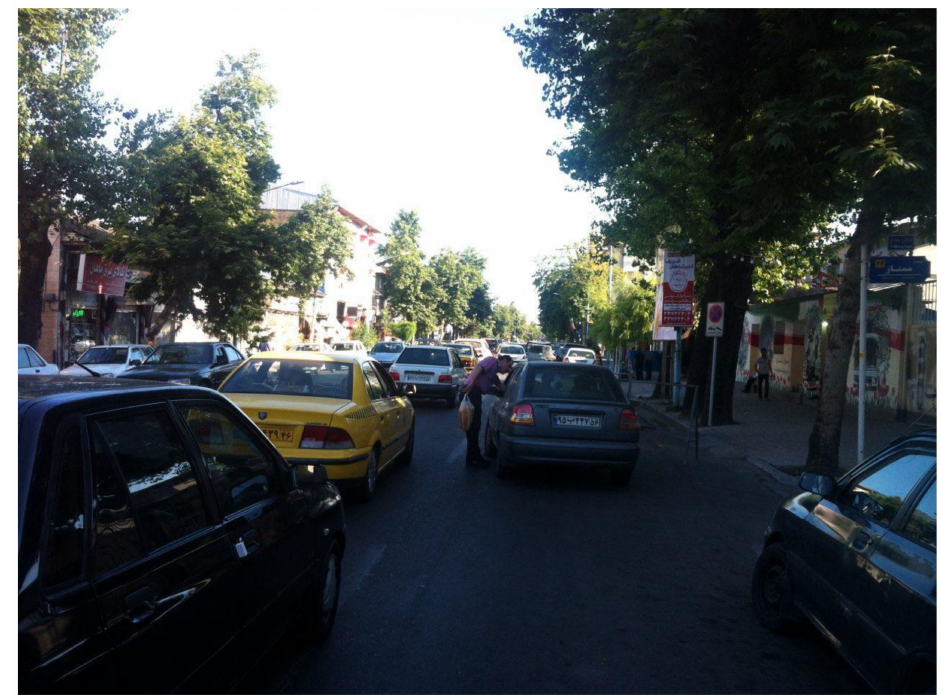
Figure 4. Congestion on the Saadi roadway